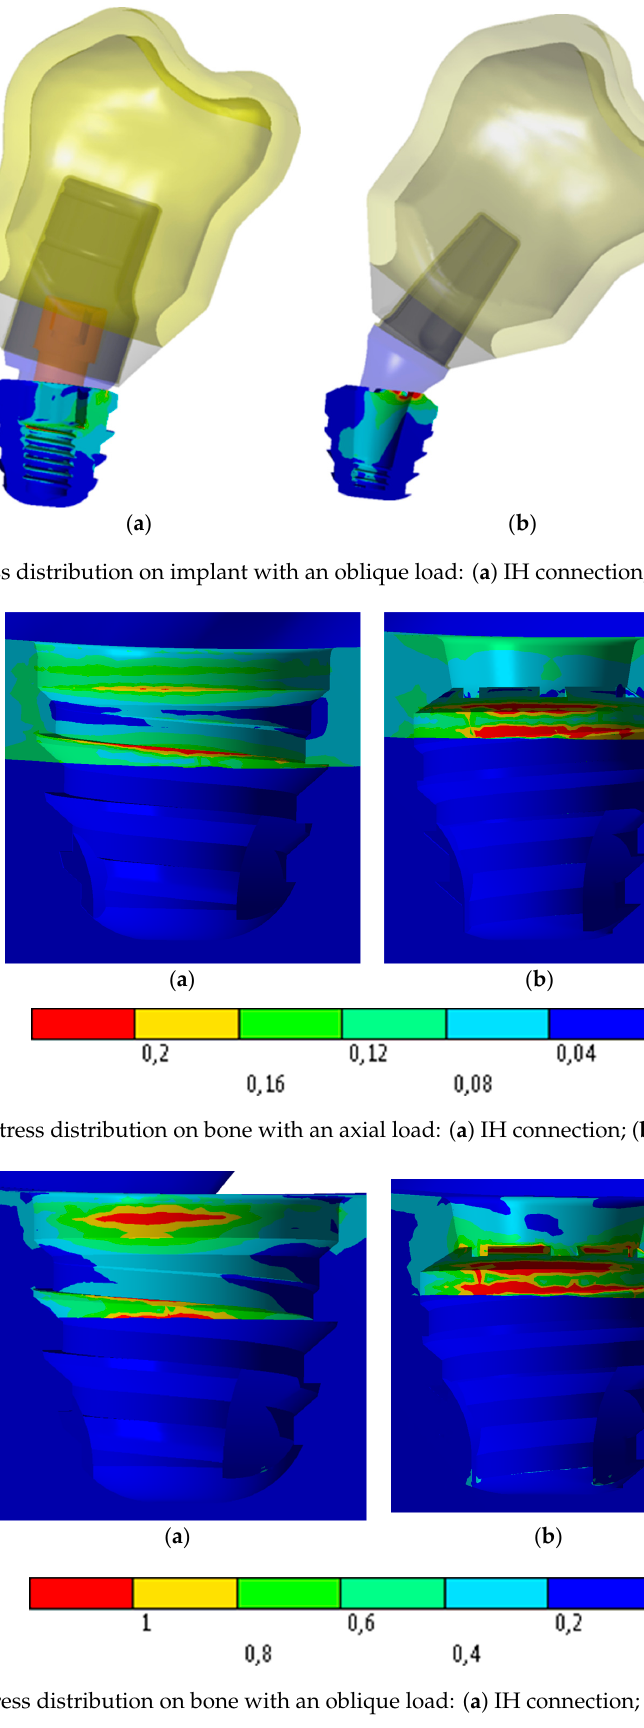
Figure 9. Stress distribution on implant with an oblique load: ( a ) IH connection; ( b ) MT connection.